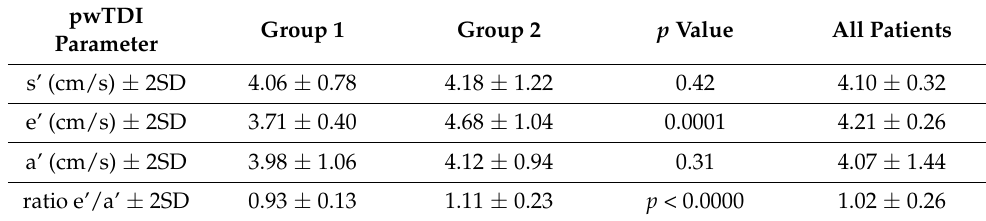
Table 2. Mean values of echocardiographic parameters obtained using the pwTDI